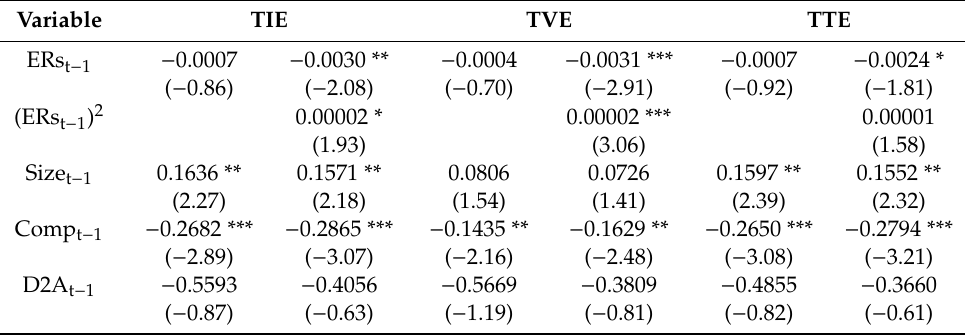
Table 6. Regression